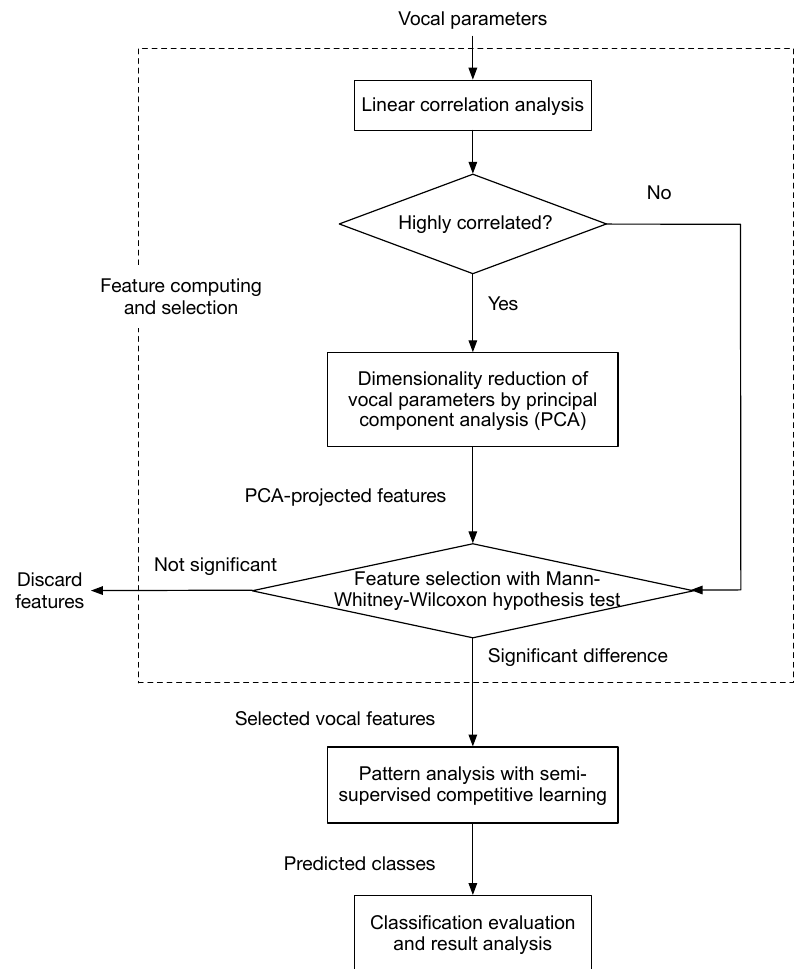
Figure 1. Flowchart of the voice detection procedures that contain vocal parameter analysis, dimen- sionality reduction, feature selection using the Mann–Whitney–Wilcoxon hypothesis test, pattern analysis based on semi-supervised competitive learning, and classification result